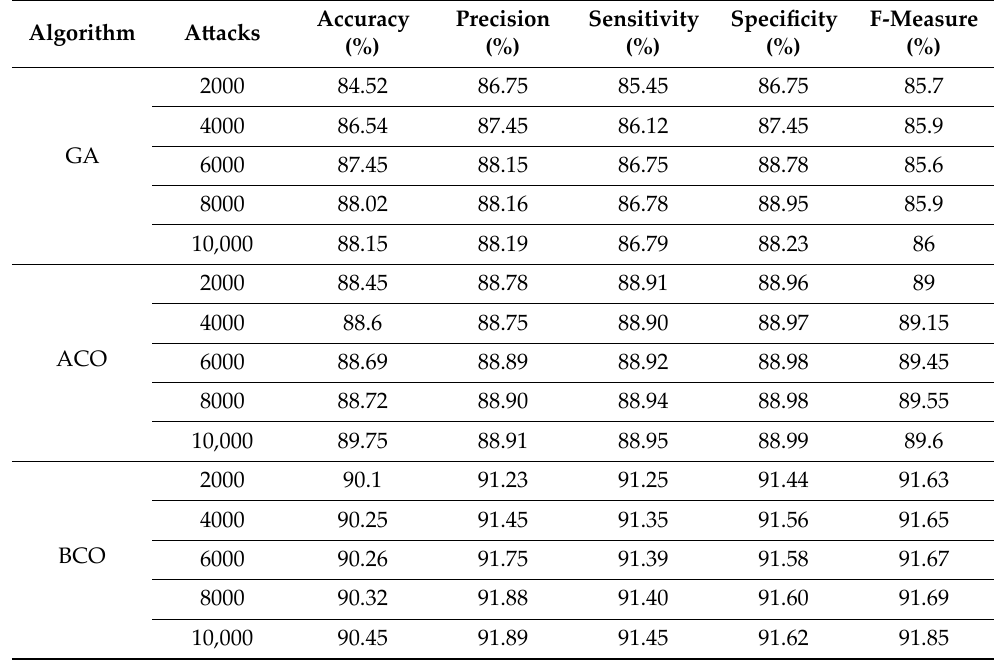
Table 9. Comparison of numerical results for proposed and existing